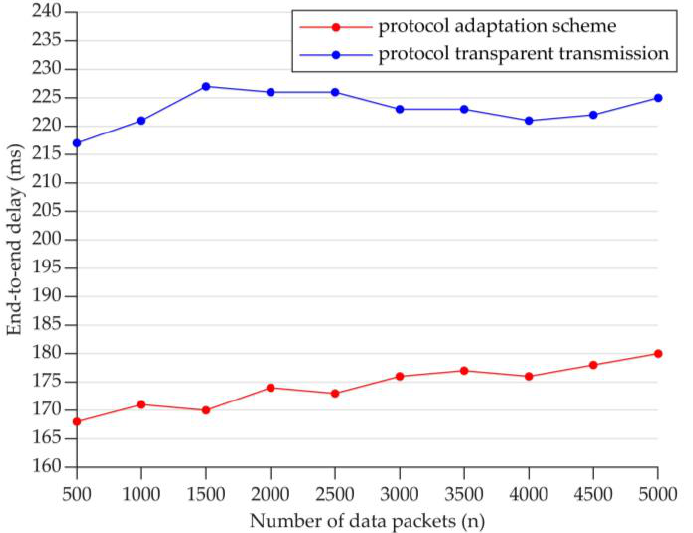
Figure 17. The end-to-end delay comparison between protocol adaptation and prototype transparent transmission for Modbus TCP.